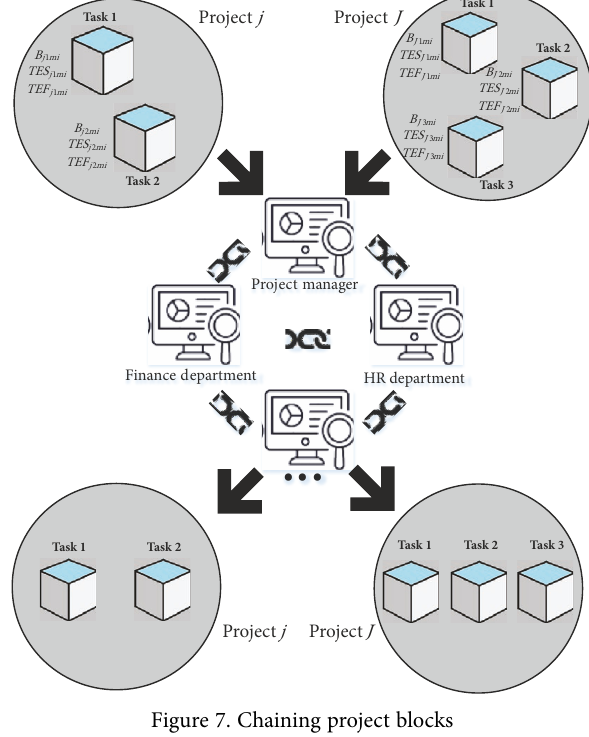
Figure 7. Chaining project